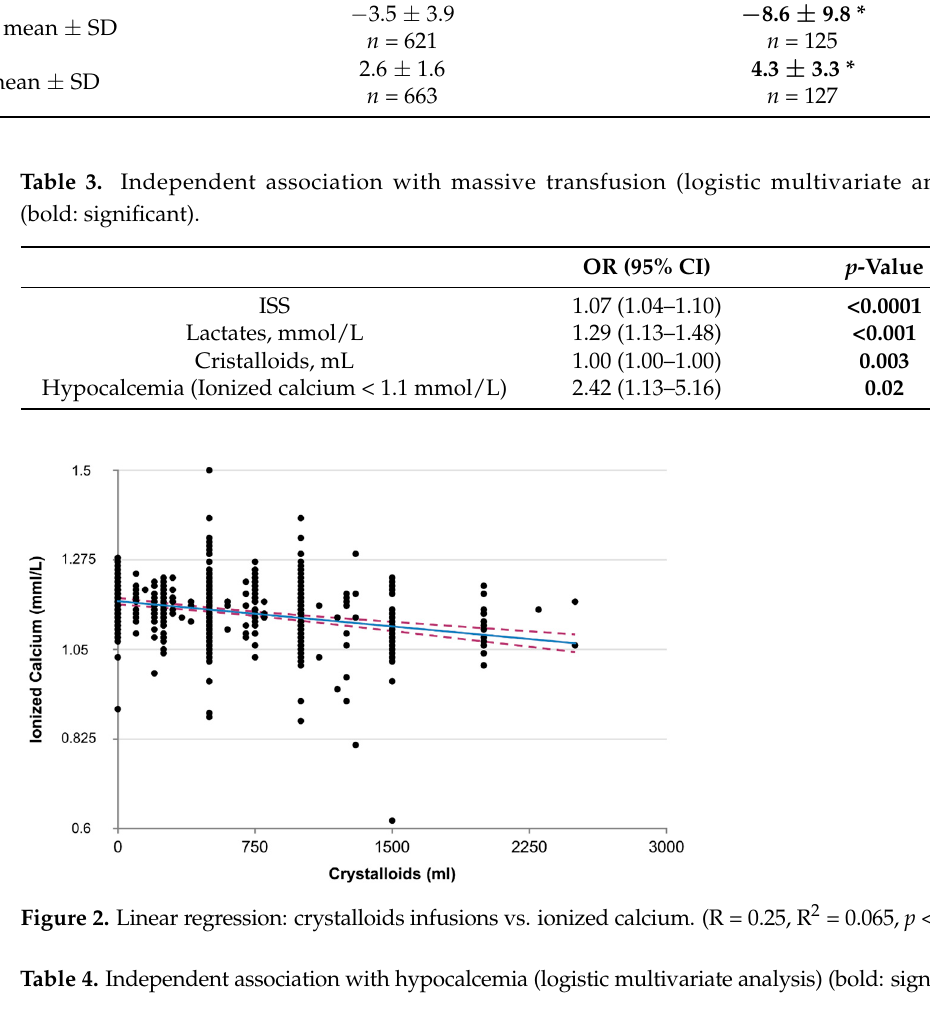
Table 4. Independent association with hypocalcemia (logistic multivariate analysis) (bold: significant)